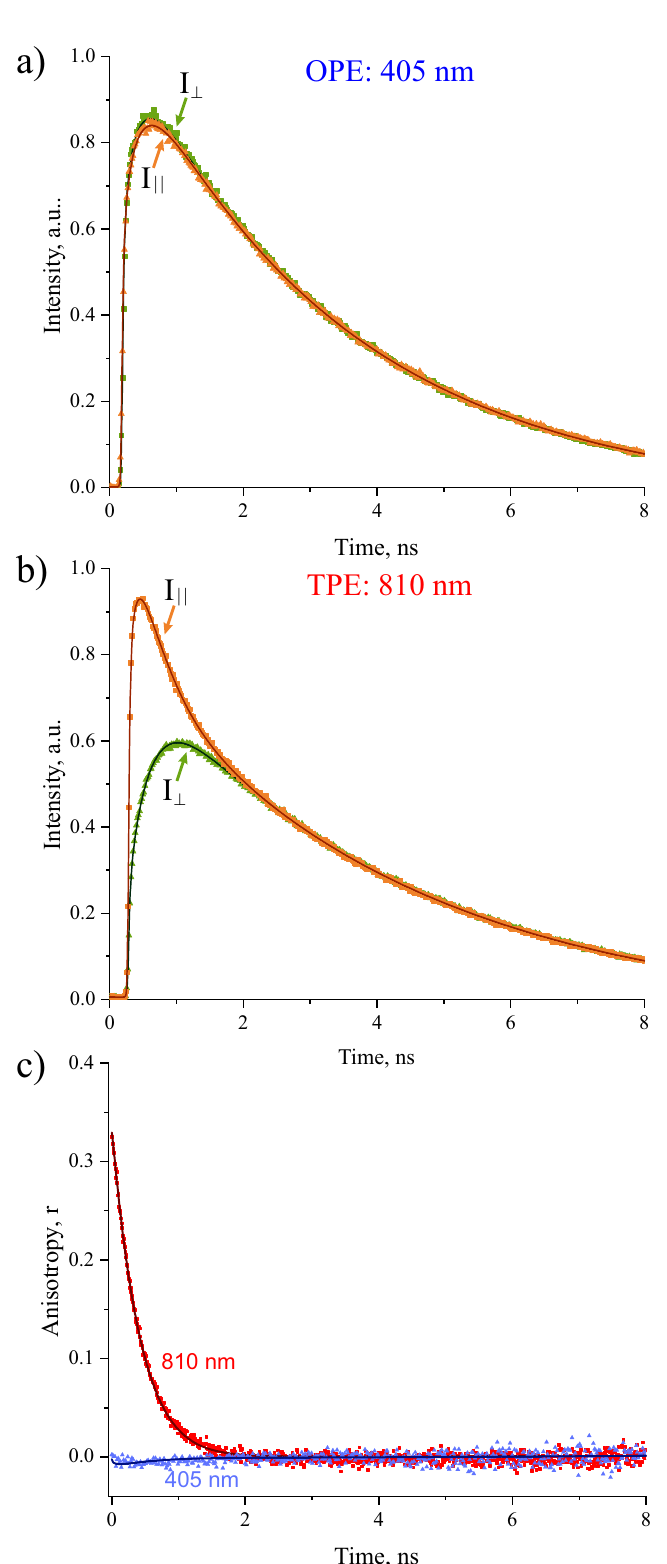
Figure 3. Decay signals of orthogonally polarized components, I (cid:107) and I ⊥ , of Radachlorin fluorescence in water under: ( a ) OPE at 405 nm and ( b ) TPE at 810 nm. ( c ) Anisotropic decay signals calculated from I (cid:107) and I ⊥ using Equation